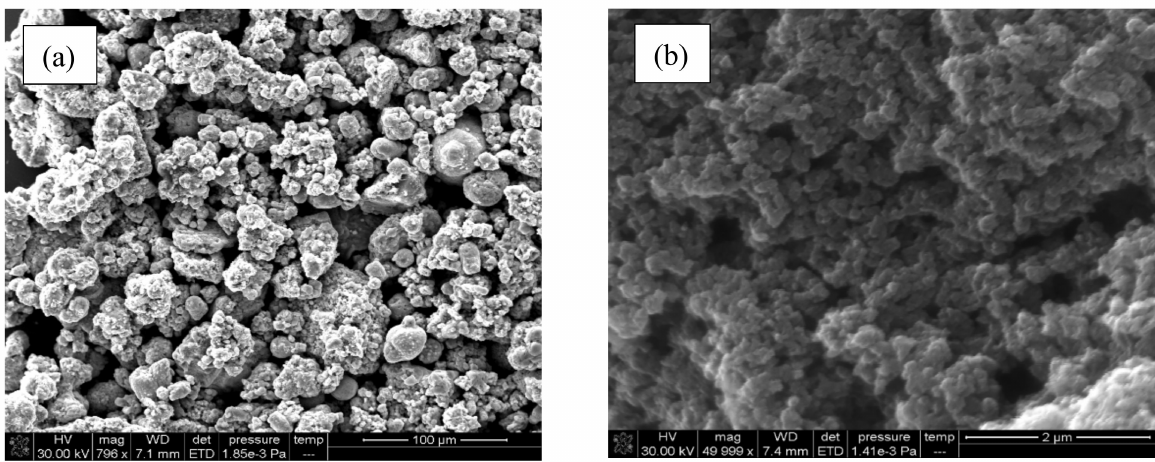
Figure 5. SEM analysis of ( a ) MgO nanoparticles and ( b ) PANI/MgO nanoparticles.